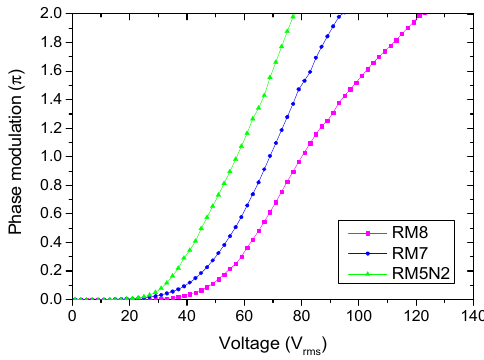
Figure 5 . Comparisons of 2 π phase modulation in RM7, RM8, and RM5N2 cells as infrared phase modulators for the light beam wavelength of λ = 1550 nm.